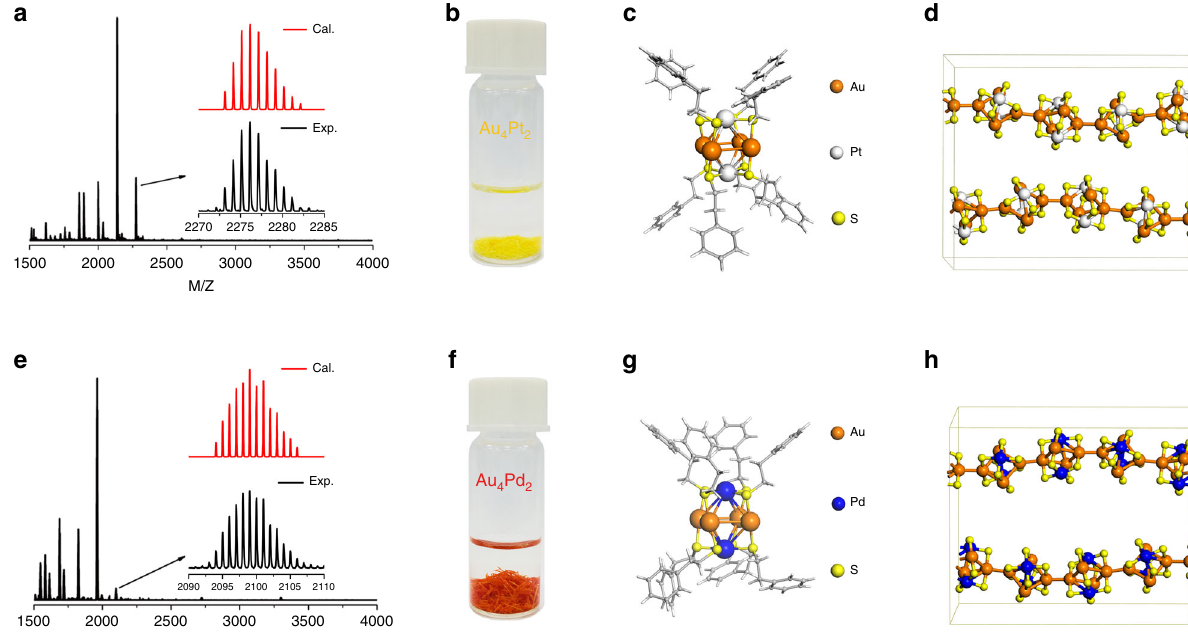
Fig. 1 Composition and structural characterization of clusters. a , e Mass spectra of Au 4 Pt 2 (SR) 8 and Au 4 Pd 2 (SR) 8 . Inset a and e illustrates the high- resolution experimental and calculated isotopic patterns of Au 4 Pt 2 (SR) 8 and Au 4 Pd 2 (SR) 8 , respectively. b , f Photographic images of the Au 4 Pt 2 (SR) 8 and Au 4 Pd 2 (SR) 8 crystals. c , g Atomic structures of the clusters and, d , h their 1D polymeric chains determined by single-crystal X-ray diffraction. Colors: golden, Au; white, Pt; blue, Pd; yellow, S; gray, C. Both C and H atoms are omitted for clarity in ( d and h